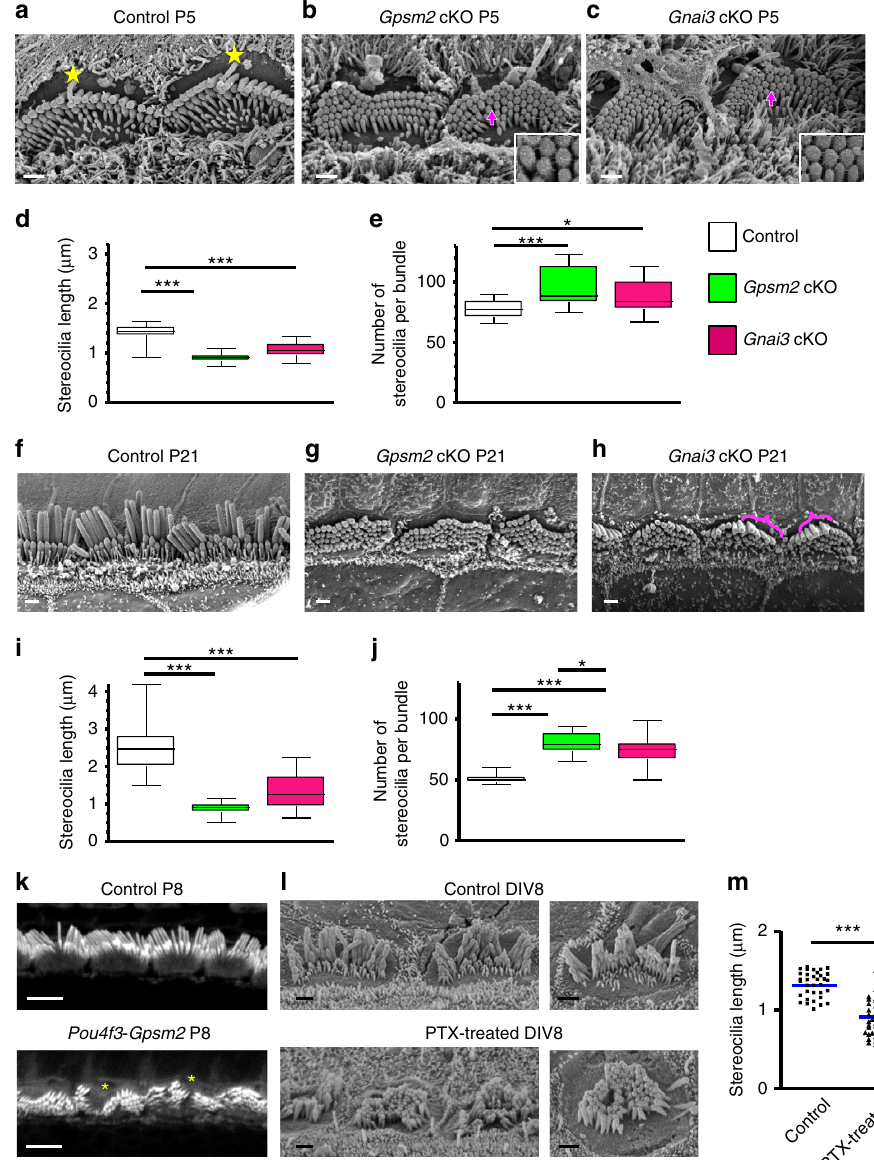
Figure 2 | Gpsm2 and Gnai3 mutations inhibit stereocilia elongation. ( a – c ) SEM of cochlear inner hair cells (IHC) from controls ( a ), Gpsm2 ( b ) or Gnai3 cKOs ( c ) in P5 mouse. The kinocilium is indicated with yellow stars. In Gpsm2 ( b ) and Gnai3 ( c ) cKOs, the staircase pattern is almost absent with stereocilia of similar length and width. Lateral links between adjacent stereocilia are preserved (magenta arrows, insets). Scale bars, 1 m m. ( d , e ) Quantifications at P5 show reduced length of IHC tallest stereocilia and supernumerary stereocilia in both Gpsm2 and Gnai3 cKOs. Quantifications are presented as whisker box plots (min/max), * P o 0.05; *** P o 0.001 with one-way ANOVA ( post hoc Bonferonni’s test). ( f – h ) SEM of basal cochlear IHC from controls ( f ), Gpsm2 ( g ) or Gnai3 cKOs ( h ) in P21 mouse. In Gpsm2 cKOs, stereocilia are short, typically with more than four rows and severely reduced staircase pattern. A similar, but weaker phenotype was observed in Gnai3 cKOs, with occasional longer stereocilia in a bundle with overall shorter stereocilia ( h , magenta brackets). Scale bars, 1 m m. ( i , j ) Quantifications at P21 are consistent with the above illustrations with a severely reduced length of IHC stereocilia and supernumerary stereocilia in Gpsm2 cKOs, and a similar but milder phenotype in Gnai3 cKOs. Quantifications are presented as whisker box plots (min/max), * P o 0.05; *** P o 0.001 with one-way ANOVA ( post hoc Bonferonni’s test). ( k ) 3D rendering of the surface of a control (top) and a Pou4f3-Gpsm2 mutant (bottom) at P8. Mutants exhibit supernumerary rows of abnormally short stereocilia, sometimes split or fragmented (yellow asterisks). Scale bars, 4 m m. ( l ) SEM of postnatal cochlear explants treated or not for 8 days (DIV8) with 100ngml (cid:2) 1 PTX. In the PTX-treated samples (bottom panels), the stereocilia are shorter than in controls (upper pannels), with similar widths. Scale bars, 1 m m. ( m ) Quantification of the length of the tallest stereocilia cultures treated with PTX (blue line ¼ mean). n ¼ 34 (control) and 76 stereocilia (PTX). Cultures repeated three times. *** P o 0.0001 with unpaired Student’s t